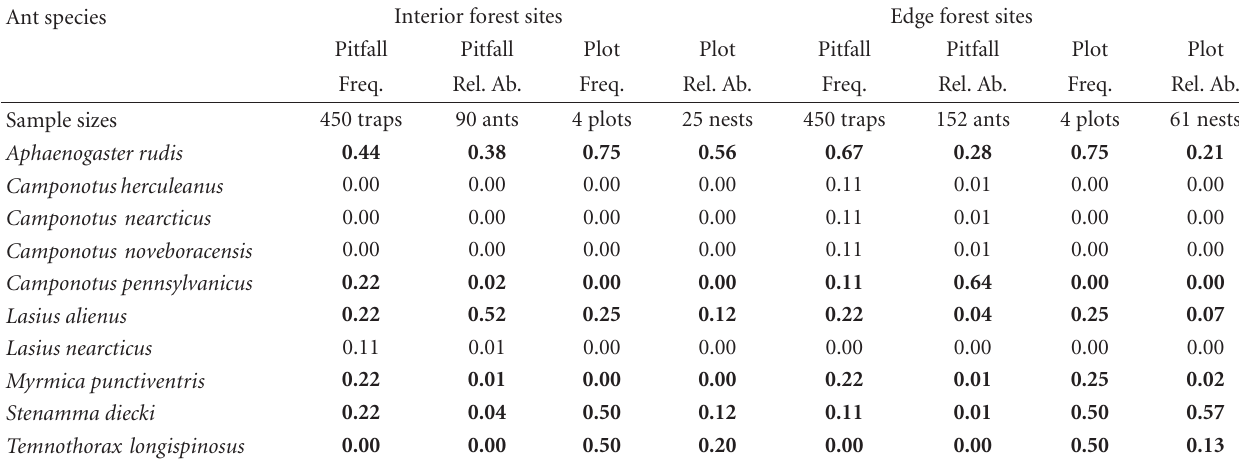
Table 1: Species composition, frequency, and relative abundance of ants. Frequency is the proportion of samples that contained individuals (in pitfall traps) or nests (on litter plots) of the species. Relative abundance is the proportion of individuals (in pitfall traps) or nests (on litter plots) of the total individuals ( n ) or nests collected ( n ). Species that were present in at least 20% of the plots or pitfall samples at either site are highlighted in bold type. In 2003, sampling was conducted on 3 dates, 1 site per date. In 2004, sampling was conducted on 2 dates, 3 sites per date.